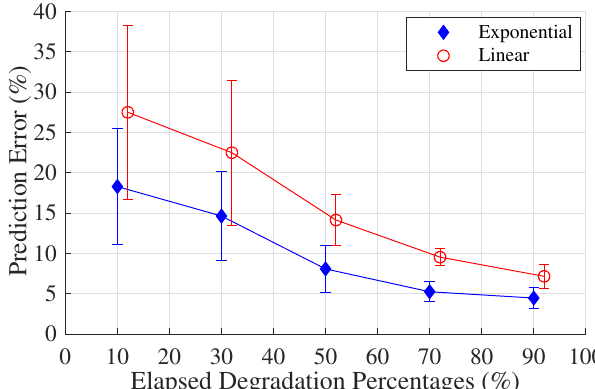
Figure 6. A comparison between the linear model and the exponential model regarding residual life prediction accuracy.